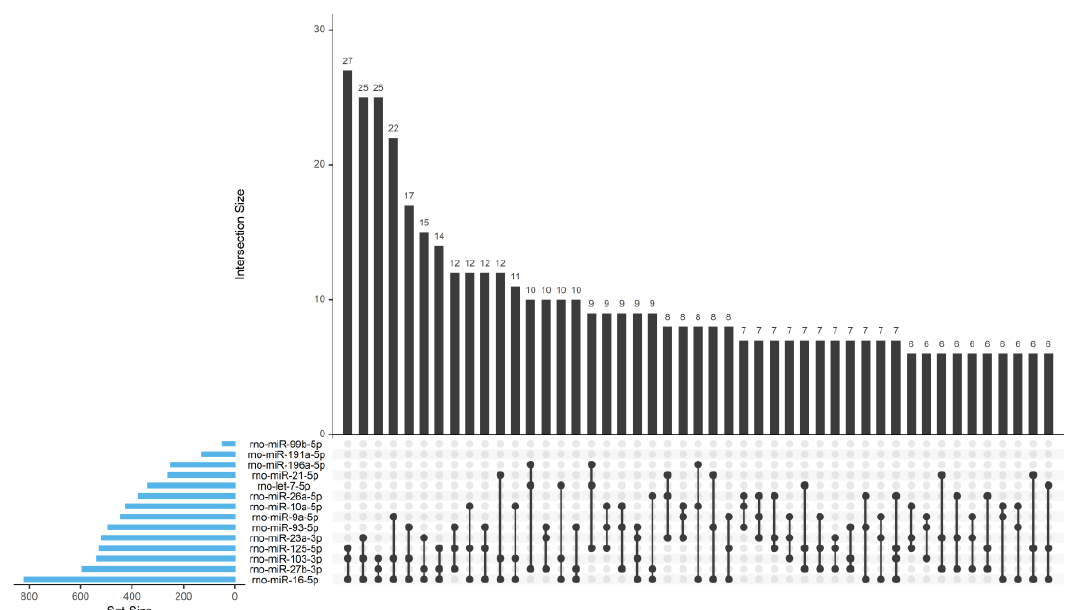
Figure 6. Characterization of WT SC-derived EV cargo in terms of miRNA content. Upset plot that shows the instances where more than 2 miRNAs target more than 5 genes. The plot is made using the R package “UpSetR”. The blue bars on the left side of the plot show the number of targets predicted for each miRNA. The right-side bar plot show the number of genes targeted by only a single miRNA (single black dot in the lower right panel) or multiple miRNAs (multiple linked dots in the lower right panel).